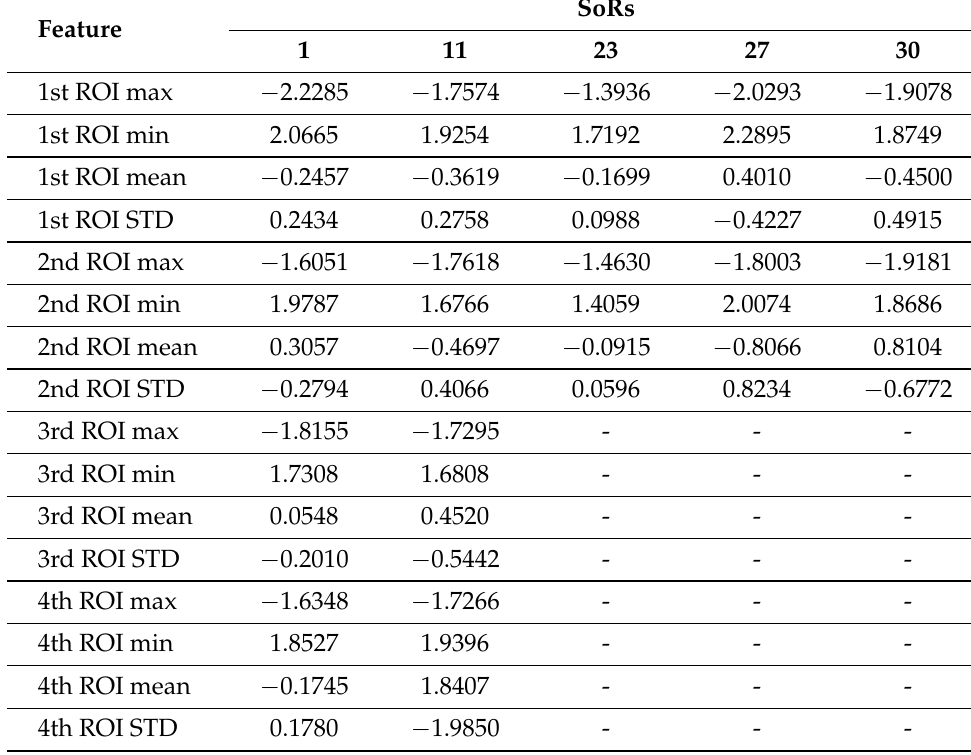
Table 10. The t -test for features on SoRs with values above required